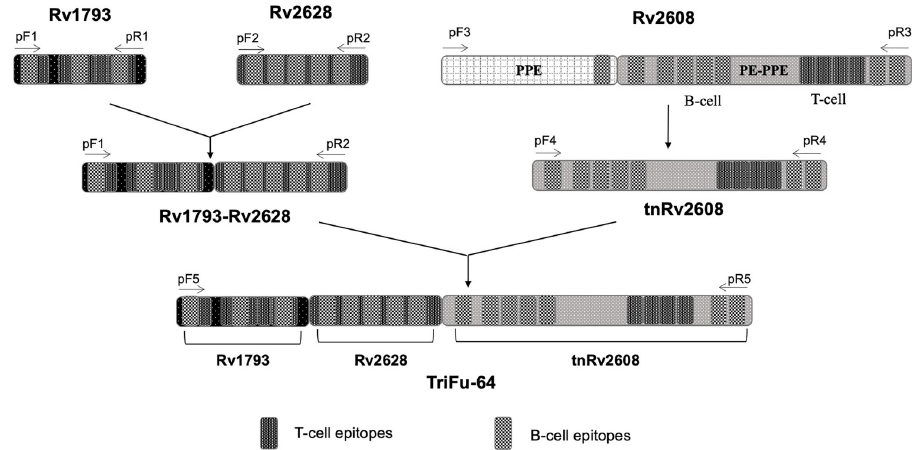
Fig 1. Schematic representation of the epitopes and construction of the single, truncated and fusion Mtb antigens. The forward and reverse primers used for each antigen and their constructs are also shown (see Table 1).